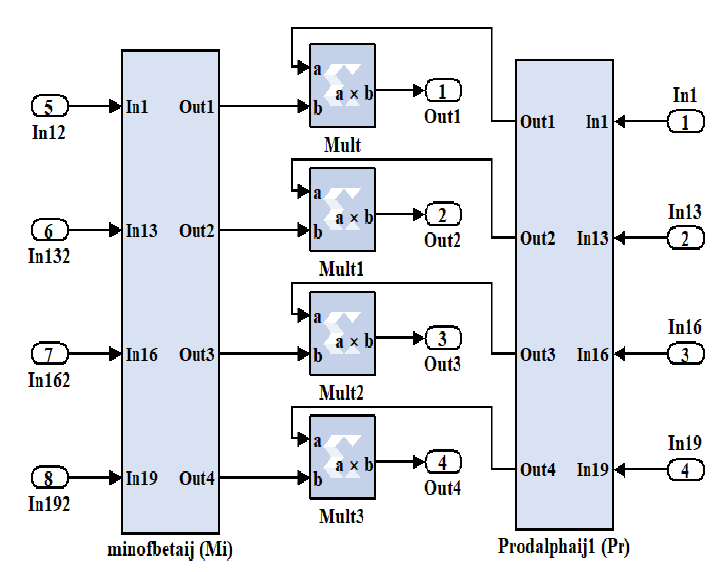
Fig. 11. The first row's horizontal step process.